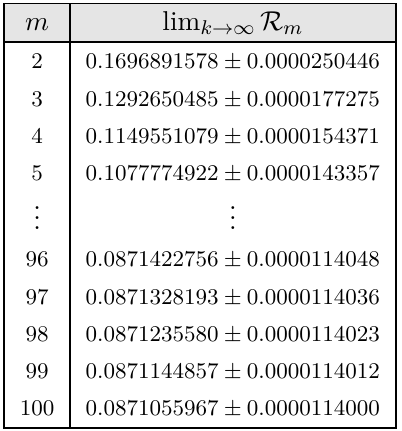
Table 5. The k → ∞ values of the Rényi entropies associated with the state | 5 1 # T 2 , 2 i .